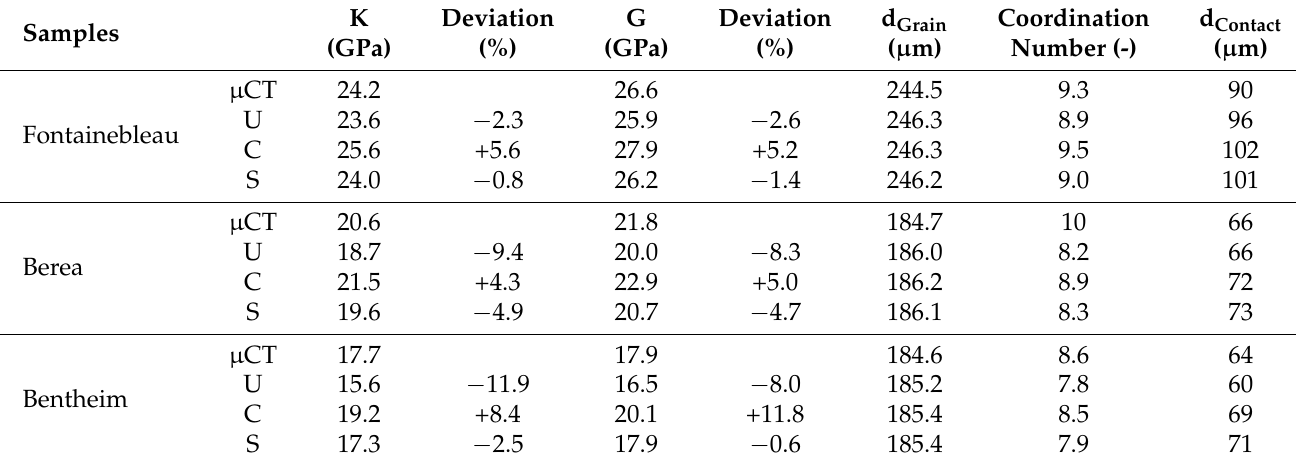
Table 3. Mechanical and related granulometric properties of the micro-CT ( µ CT) scans and the synthetic sandstone samples cemented by the three different schemes (U, C, S).